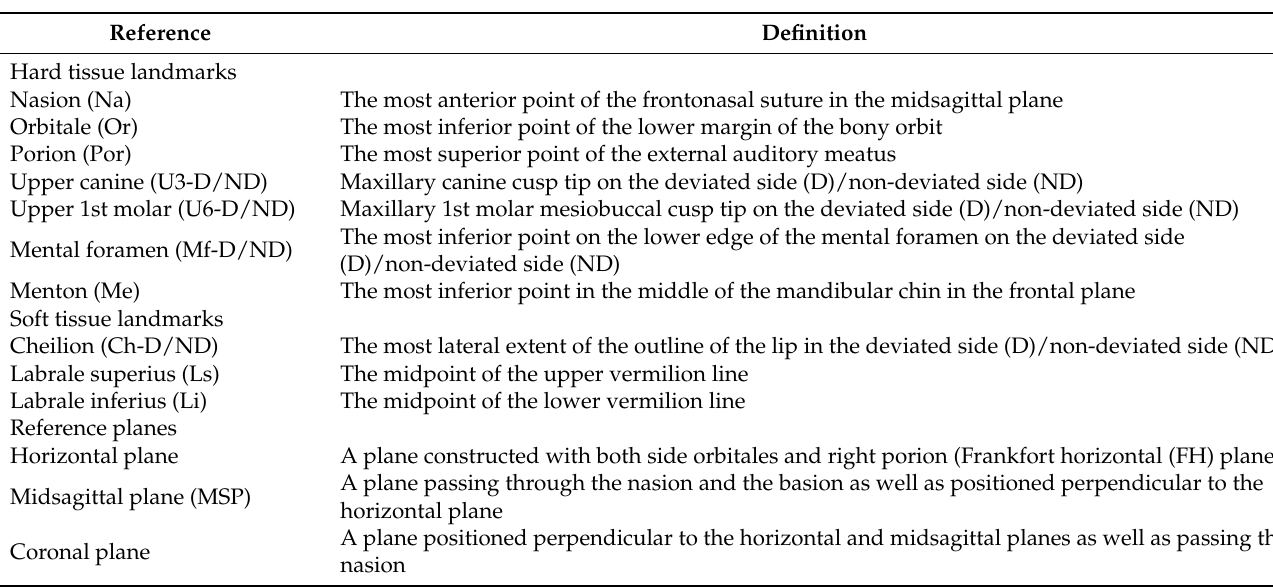
Table 2. Landmarks and reference planes used in this study.